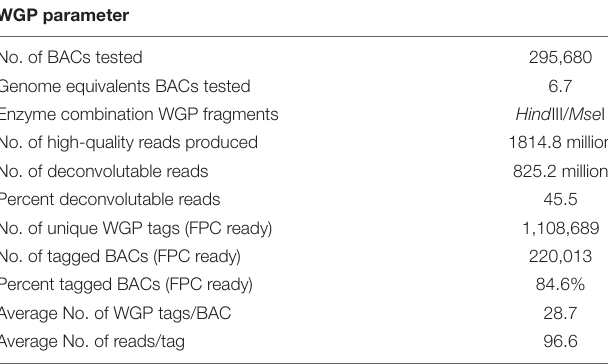
TABLE 1 | Summary of whole genome profiling (WGP) input parameters and sequence data processing. WGP parameter